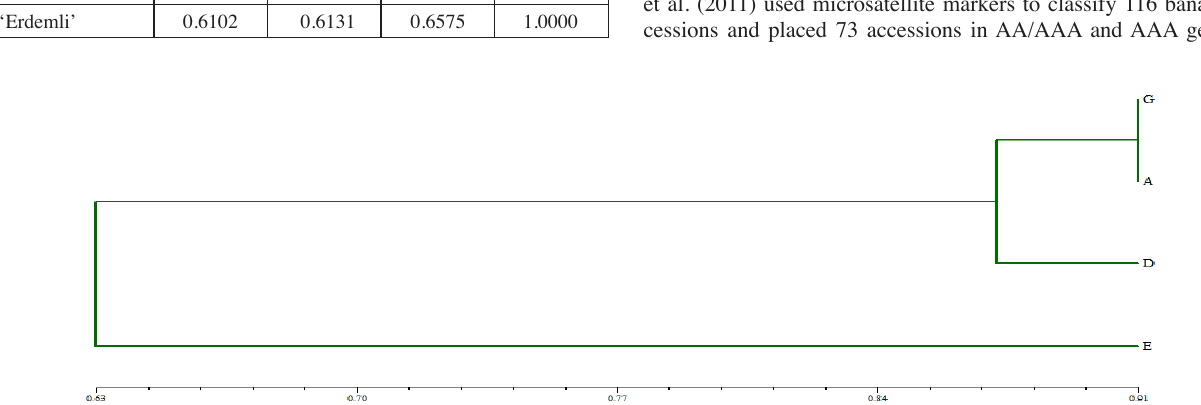
Fig. 1: Dendrogram of 4 banana clones using UPGMA method obtained from SRAP markers, E: ‘Erdemli’, A: ‘Azman’, D: ‘Dwarf Cavendish’, G: ‘Grand